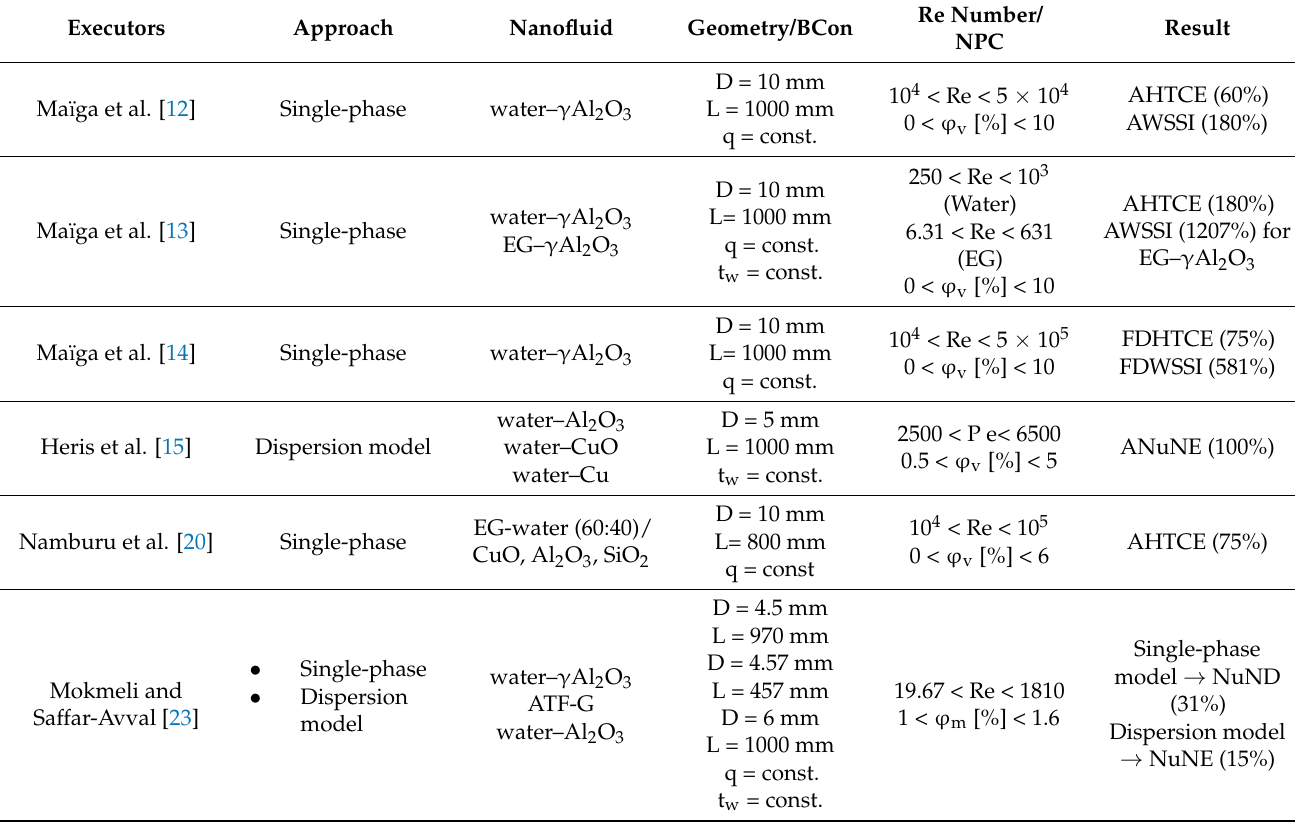
Table 1. Numerical studies dealing with single-phase